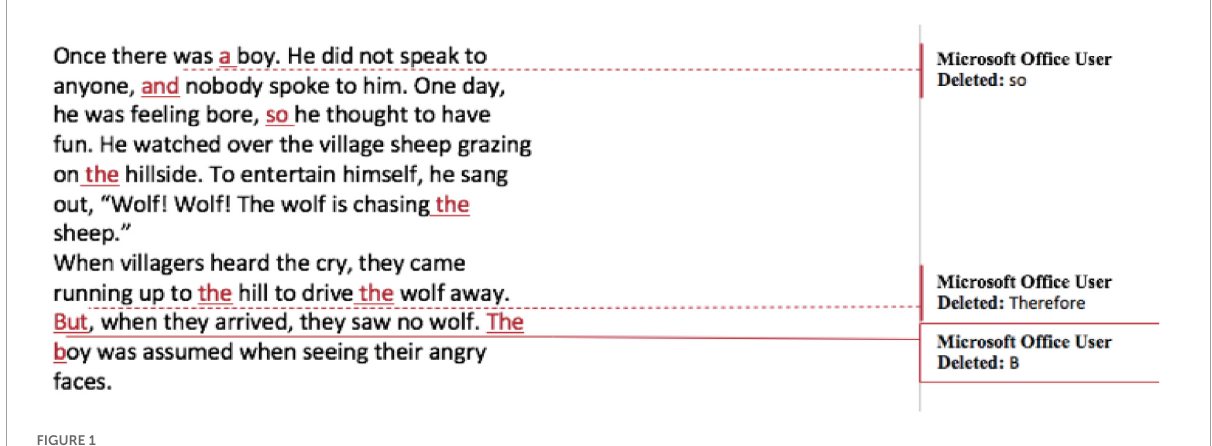
FIGURE1 Learners’ corrections using the MS Word Track Changes